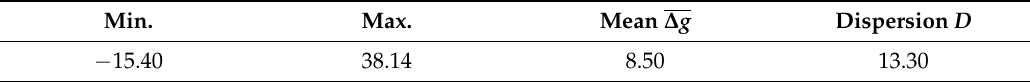
Table 1. Statistical characteristics of the gravity anomaly observations along the route (unit: